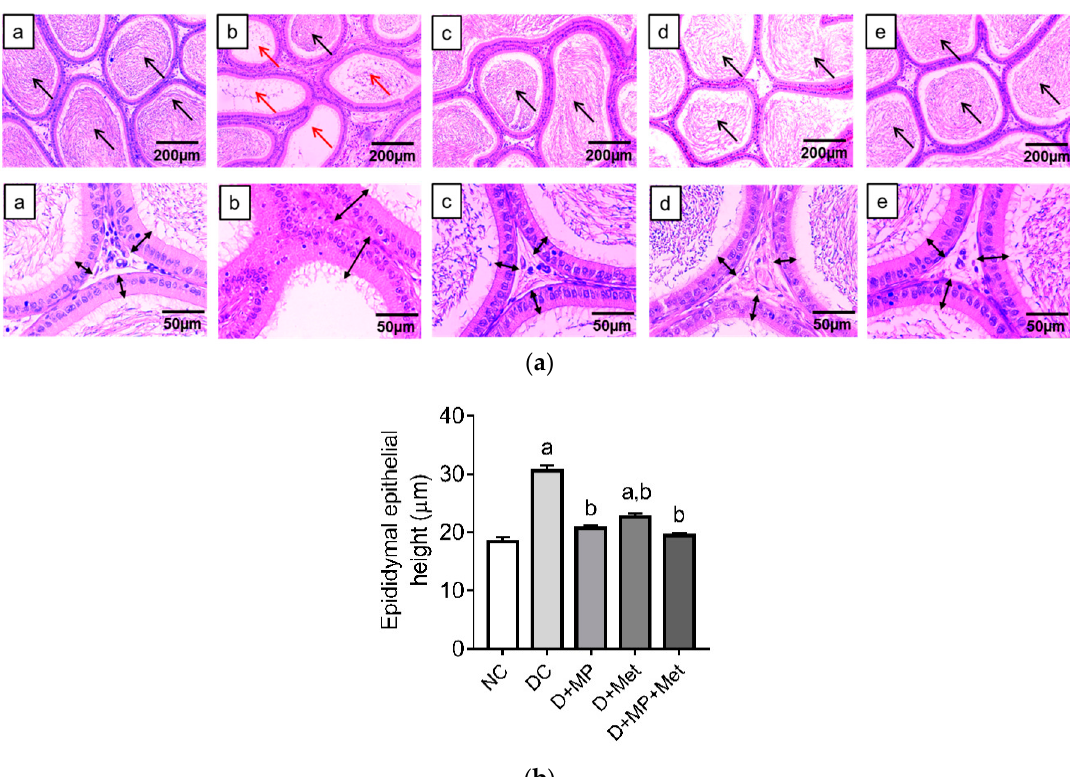
Figure 3. Representative photomicrographs of the caudal epididymis in ( a ) NC, ( b ) DC, ( c ) D+MP, ( d ) D+Met and ( e ) D+MP+Met groups ( a ). Histology of the epididymis of DC group showed large areas with decreased sperm density (red arrows) and increased epithelial height, relative to the NC group and treated groups ( c , d , e ) which showed large areas with high sperm density (black arrows) (haematoxylin and eosin staining, magnification: ×100 and ×400; scale bar: 200 μ m and 50 μ m for upper and lower panels, respectively). For ( b ) epithelial height, values are mean ± SD, n = 8. a p < 0.05 versus NC, b p < 0.05 versus DC (one ‐ way ANOVA followed by Tukey’s post ‐ hoc test). NC: normoglycaemic control, DC: diabetic control, D+MP: diabetic rats treated with Malaysian propolis, D+Met: diabetic rats treated with metformin, D+MP+Met: diabetic rats treated with Malaysian propolis + metformin.